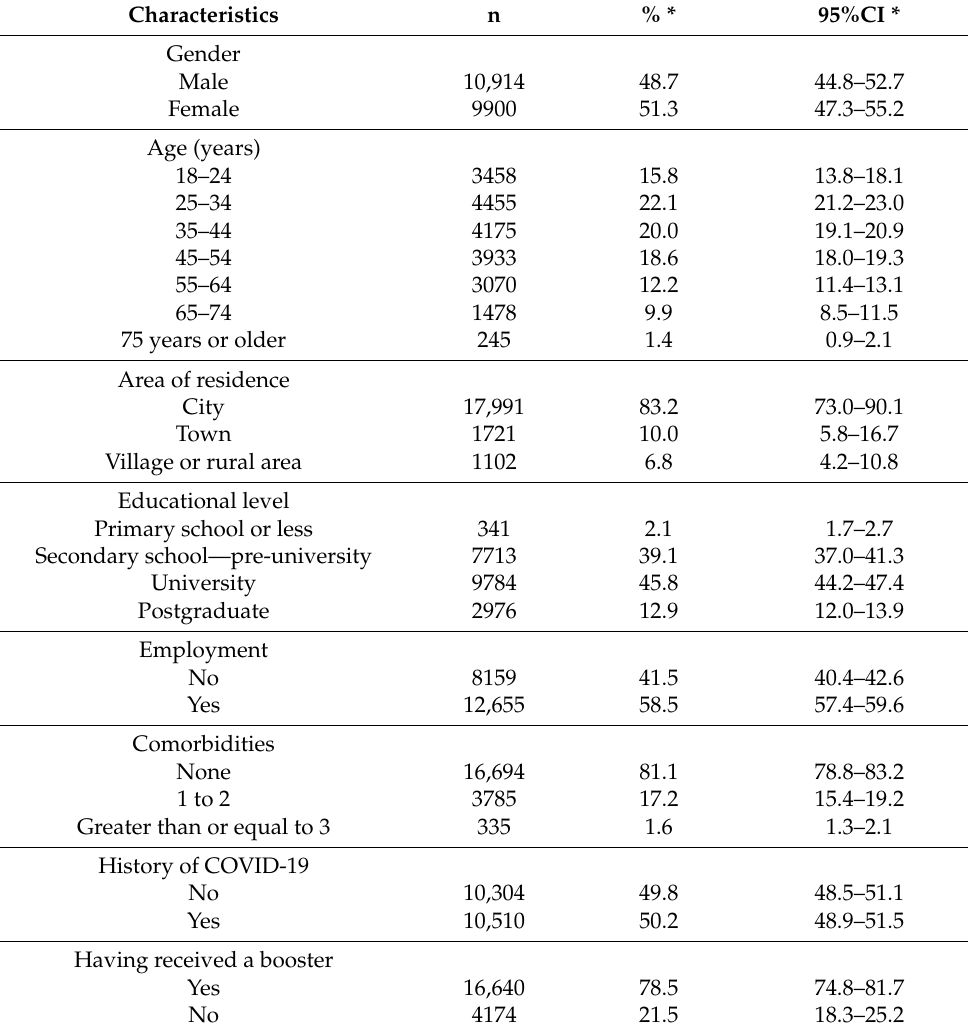
Table 1. Characteristics of the study sample (n = 20,814).